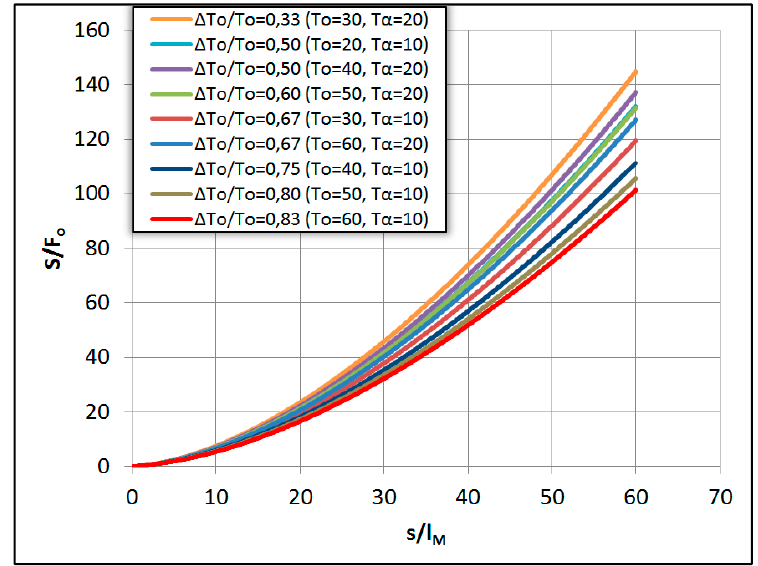
Figure 3. Dimensionless average dilution S/F o as a function of s/ l M of positively buoyant heated jets for θ ο = 45°, F o = 100, T o = 20–60 °C, Τ α = 10–20